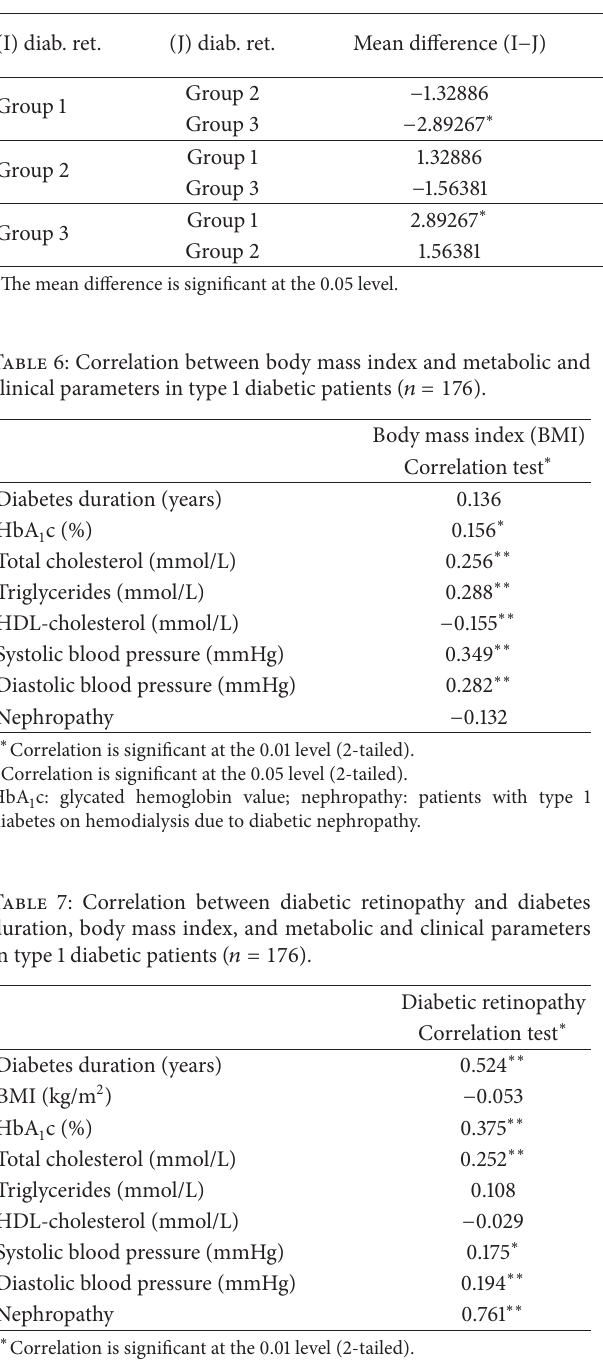
Table 5: Scheffe’s post-hoc test : dependent variable body mass index (BMI) of type 1 diabetic patients ( 𝑛 = 124 ) without nephropathy was divided into three groups according to diabetic retinopathy status.